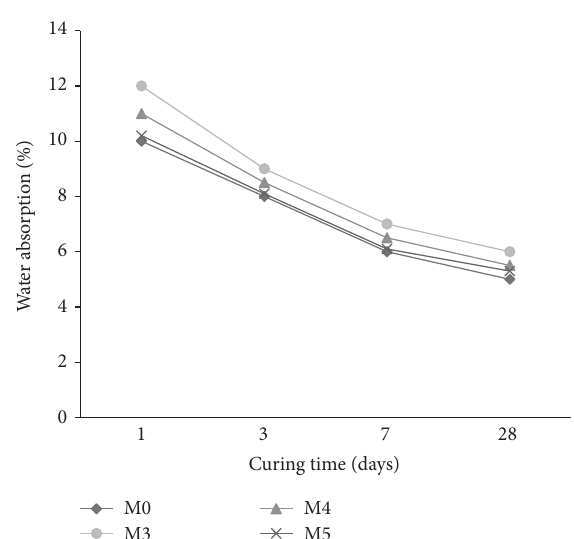
Figure 6: The effect of copolymer latexes prepared in presence of DBSS/PVA on the water absorption of mortar.